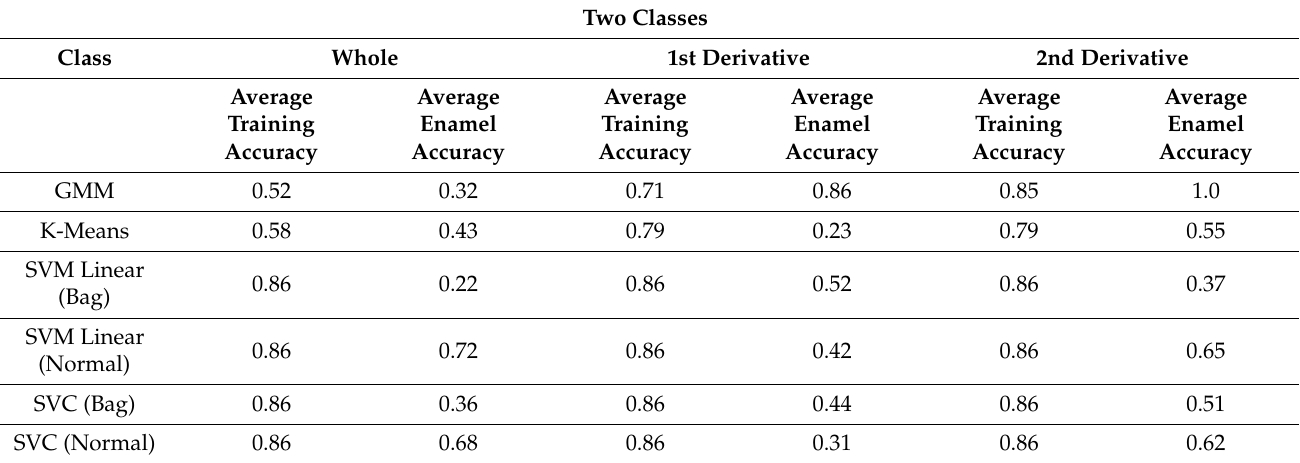
Table 1. Average training and enamel classification accuracy for each trained model type for two classes. Two Classes